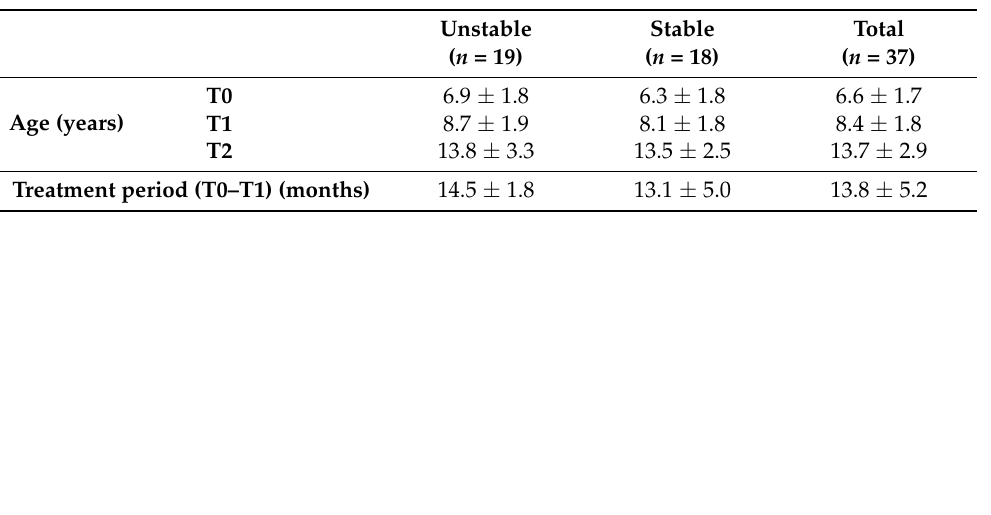
Table 2. Demographic characteristics of the study